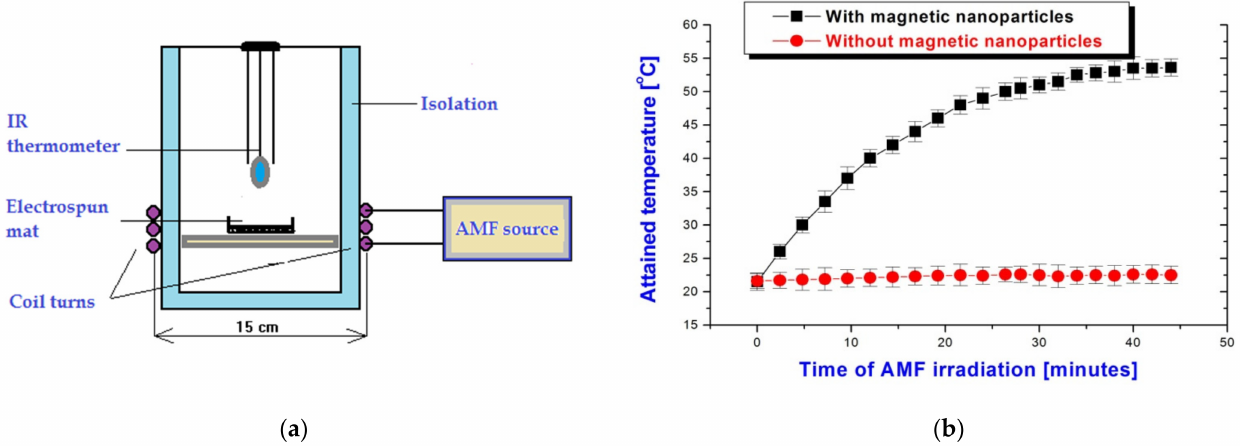
Figure 4. Alternating magnetic field was used for heating of nanofibers with embedded magnetic nanoparticles: ( a ) experimental setup; ( b ) kinetics of temperature increase in nanofiber patch with magnetic